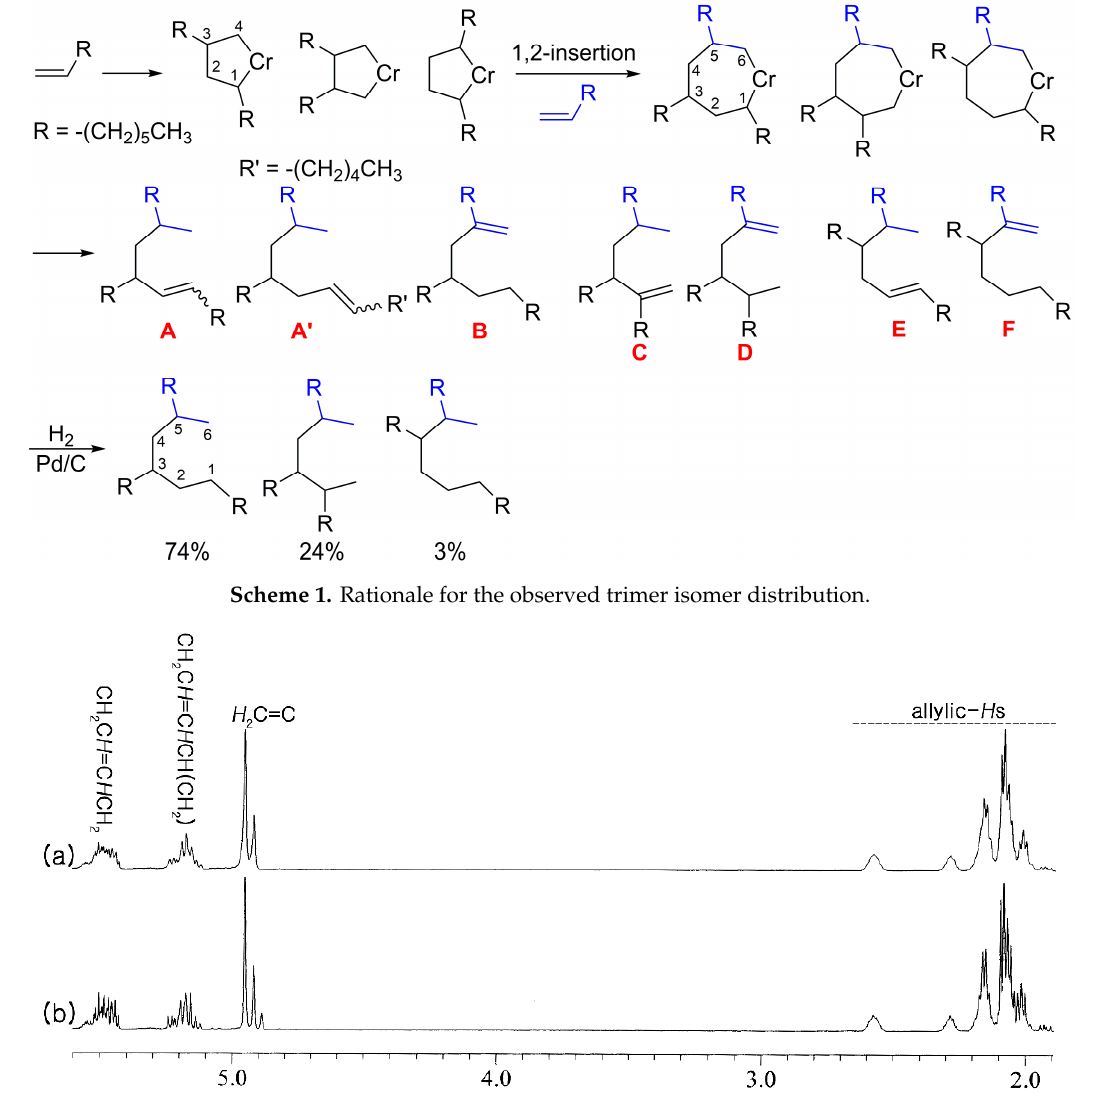
Figure 3. 1 H NMR spectra of 1 ‐ octene trimer generated at ( a ) 25 °C and ( b ) 60 °C.